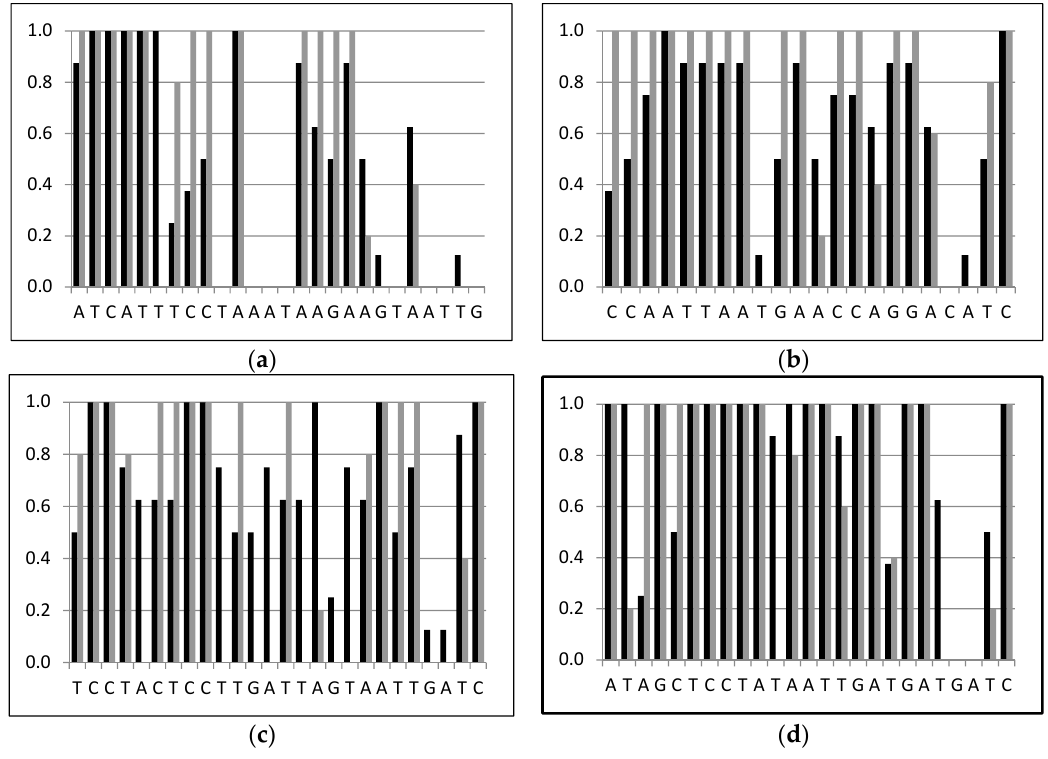
Figure 2. Similarity comparison between the specific primers Asco ( a ); Peri ( b ); Pristo ( c ); and Tricho ( d ) and the non-specific parasitoid (black) or the tortricid host (grey) sequences. Table 2. Description of the PCR primers used to amplify different parts of the COI gene for the